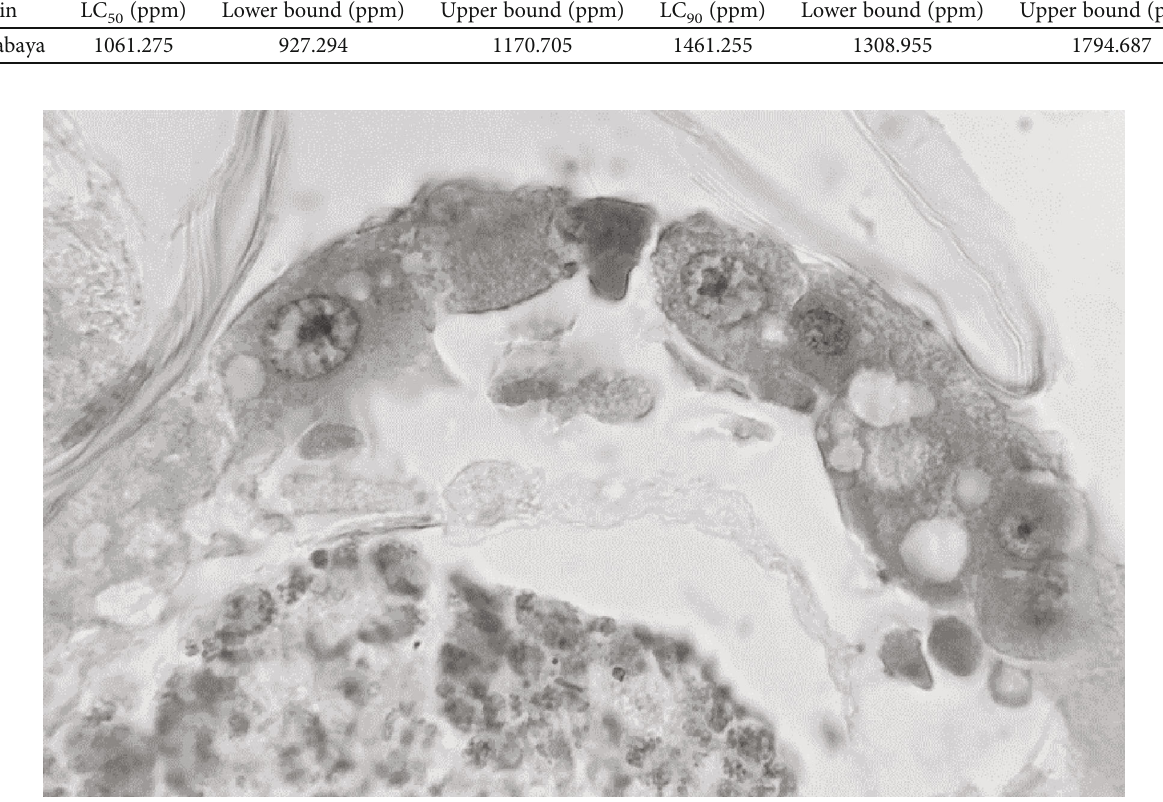
Figure 1: Cross-section part of the midgut of 3th instars larvae of Ae. aegypti larvae midgut exposed to 2000 ppm Averrhoa bilimbi extract for 24 hours. lm: lumen, v: vesicle, n: nucleus, mv: microvilli, mb: basal